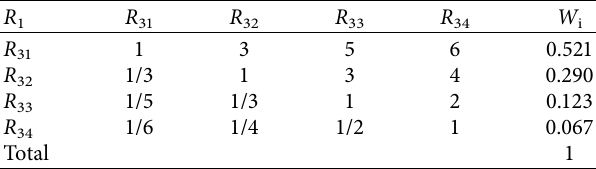
Table 6: Weight of financial capital in second-level indicators.